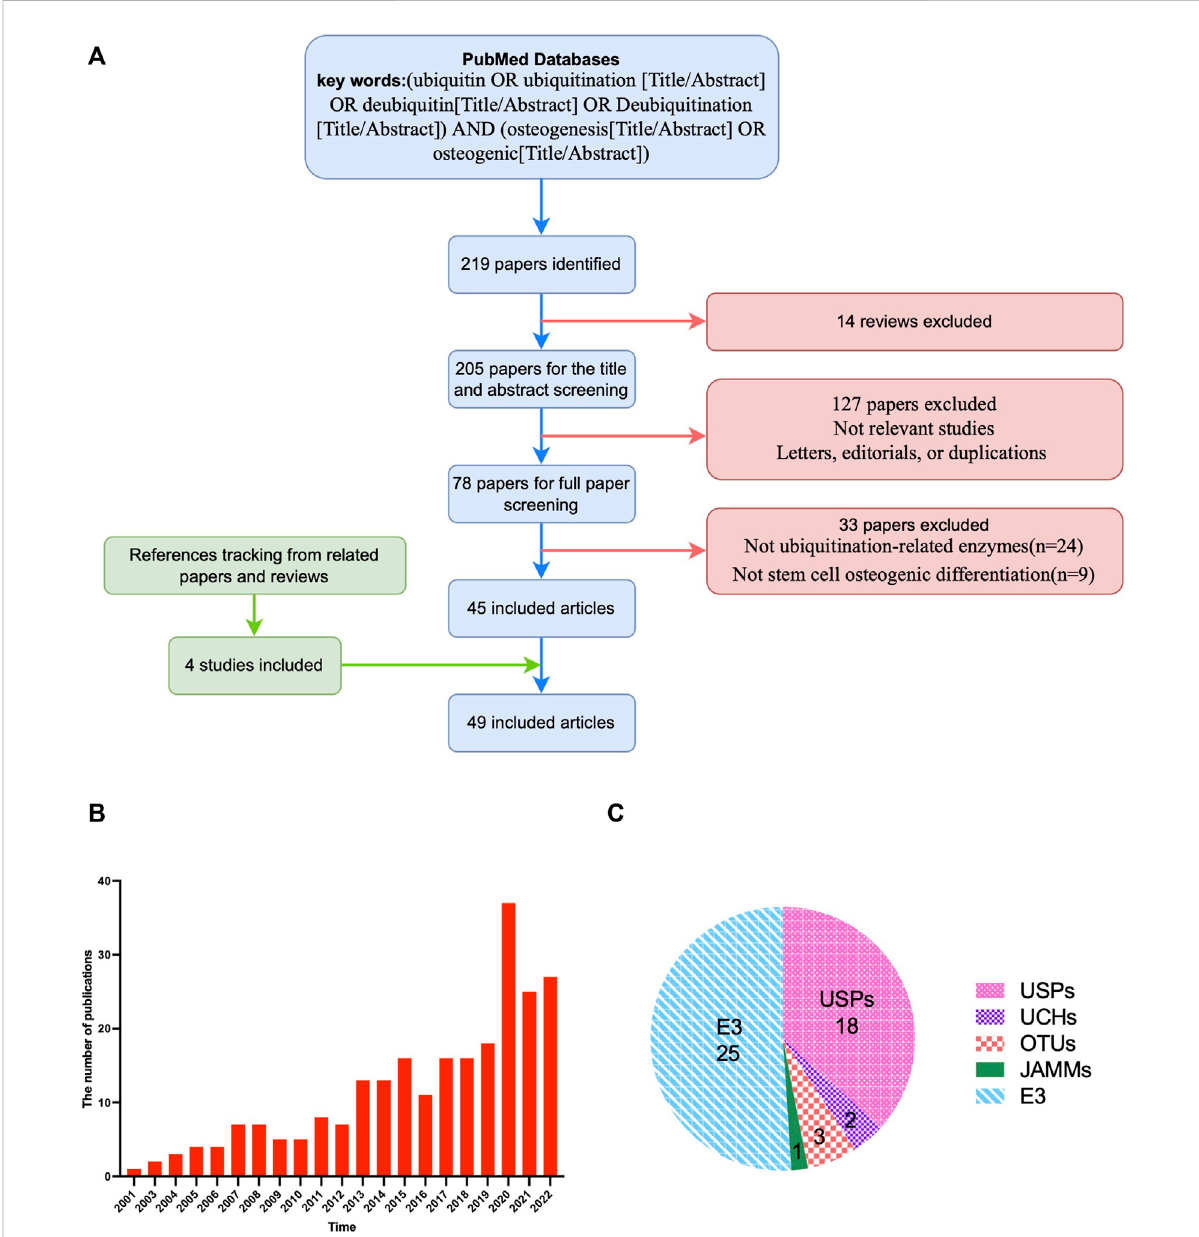
FIGURE 1 Overview of the included articles for the role and mechanism of ubiquitin modi fi cation in osteogenic differentiation of stem cells. (A) , Flow diagram illustrating the study screening and inclusion process. (B) , Statistics for the numbers of publications in different years. (C) , Types of enzymes of the included articles. The number refers to the number of relevant literatures. USPs, ubiquitin-speci fi c proteases; UCHs, Ubiquitin C-Terminal Hydrolase; OTUs, ovarian tumor-related proteases; MJDs, Machado-Josephin domain proteases; JAMMs, Jabl/MPN domain associated metalloisopeptidase; E3, ubiquitin